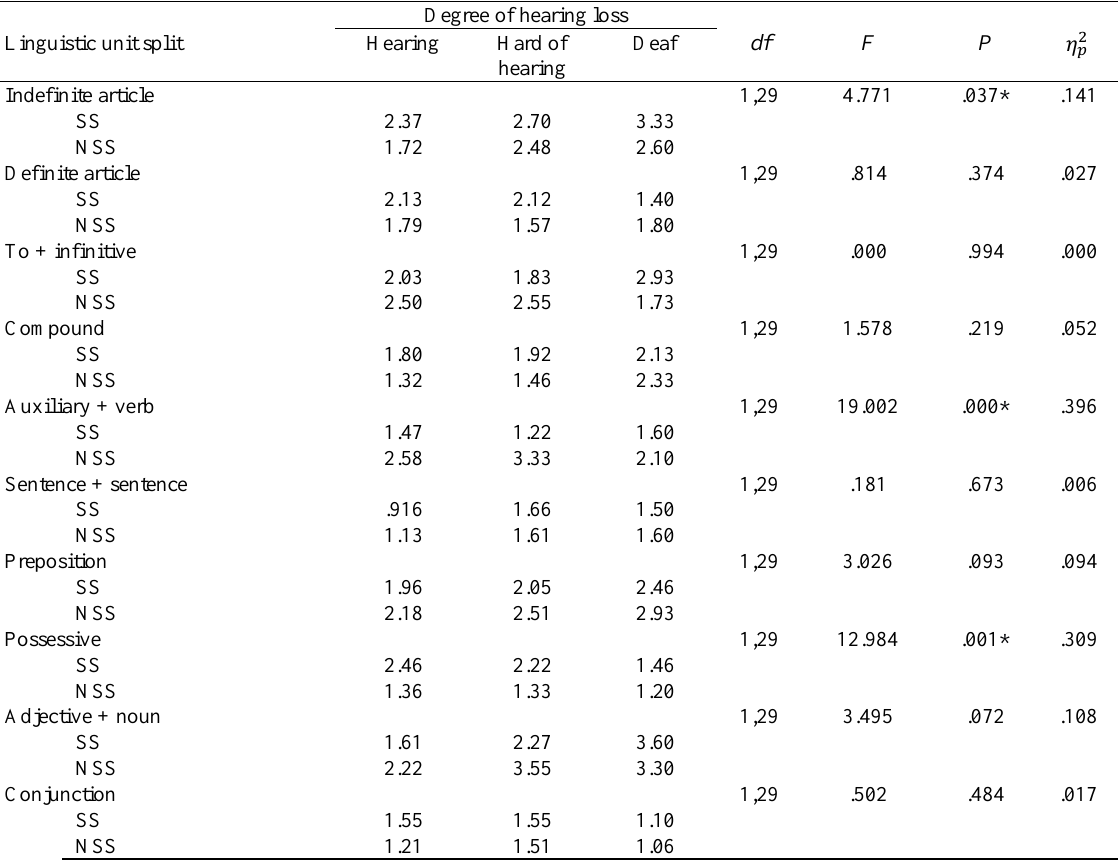
Table 11. Revisits by linguistic unit and segmentation.